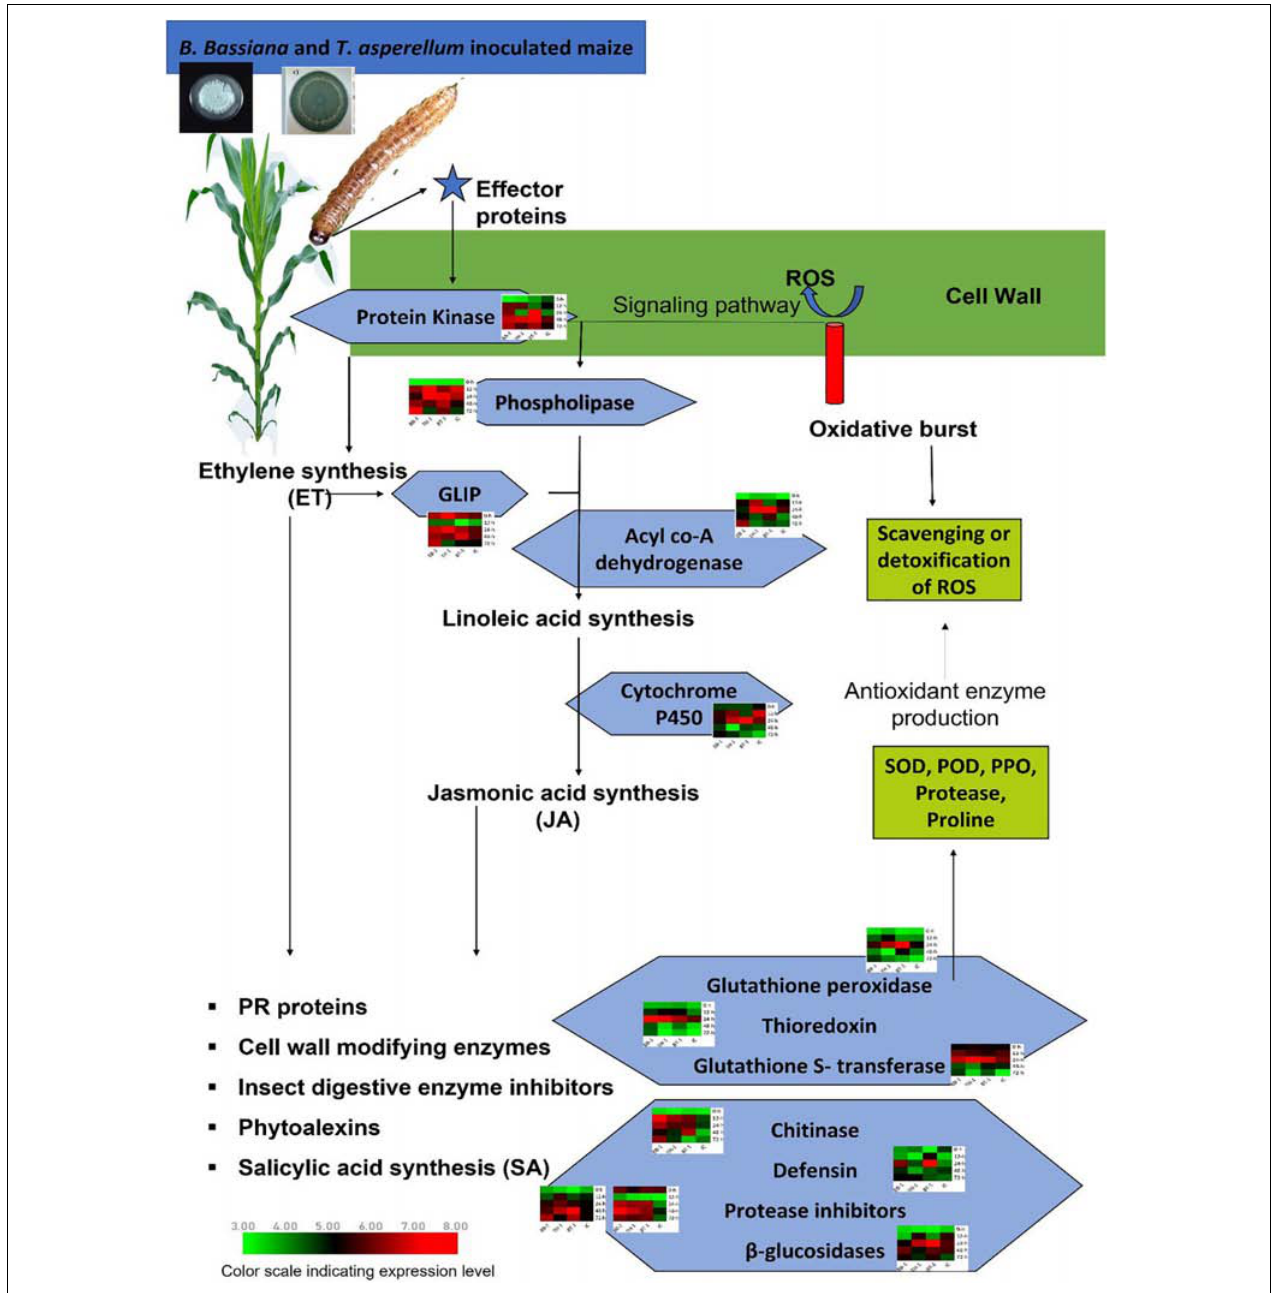
FIGURE 6 | Schematic representation of transcriptional strategies employed by maize inoculated with a consortium of B. bassiana OFDH1-5 and T. asperellum GDFS1009 compared with single inoculation to induce enhanced expression of key genes to involve in initiating signaling pathway to activate phytohormone biosynthesis pathways which regulate the production and expression of defense genes to induce maize resistance against O. furnacalis . Treatments include (BB-1) seed treatment with B. bassiana OFDH1-5, (TH-1) seed treatment with T. asperellum GDFS1009, (BT-1) seed treatment with a consortium of B. bassiana OFDH1-5 and T. asperellum GDFS1009, (IC) no